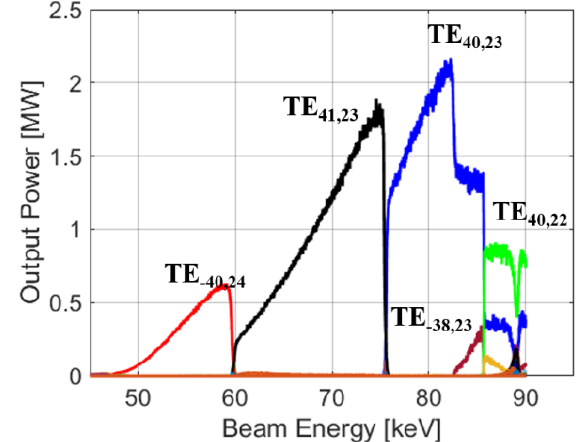
Fig. 8. Realistic start-up scenario with a shortened coaxial cavity length at 6.88 T and I beam = 75 A using the magnetic field profile proposal from the new SC magnet and the gun parameters from the new coaxial